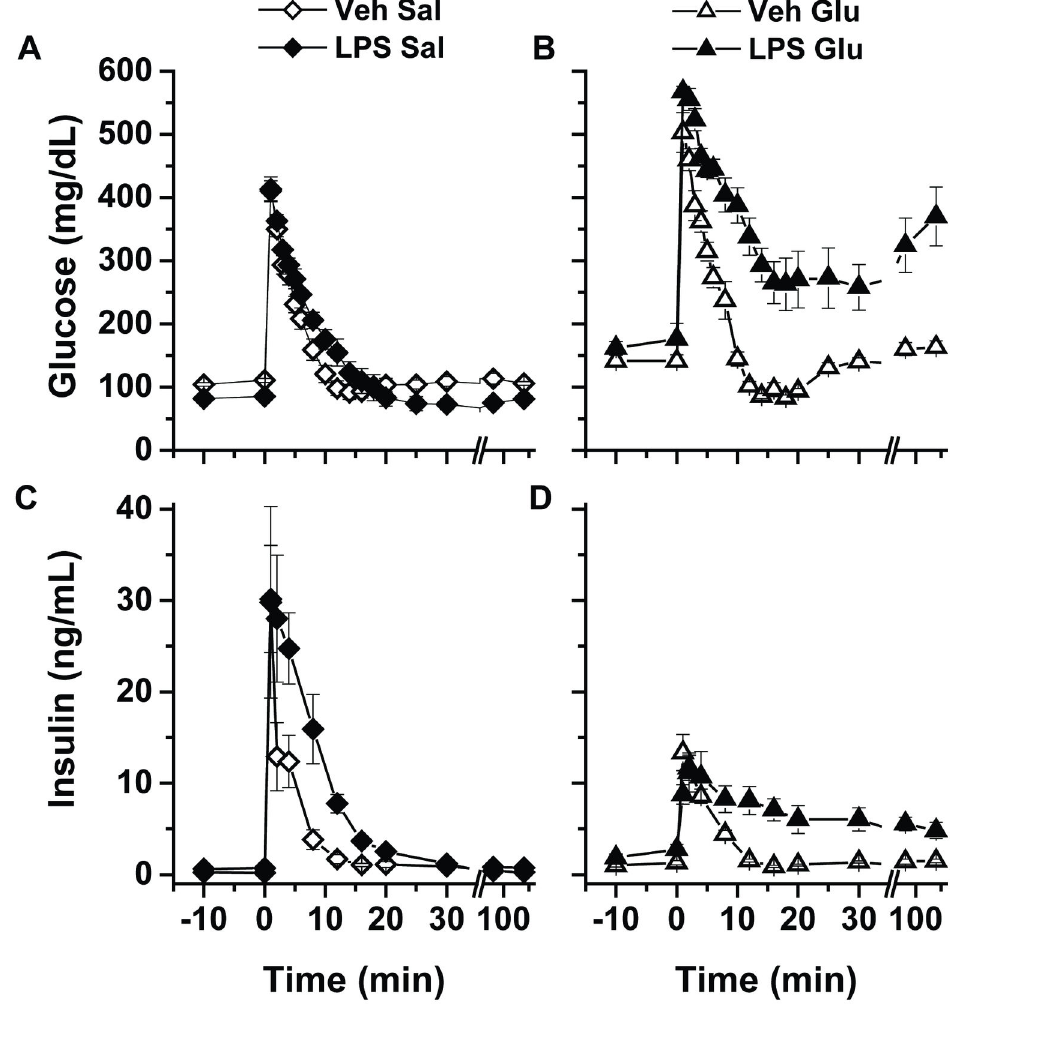
Figure 4. Frequently sampled intravenous glucose tolerance test data. Glucose disposal curves in response to an iv injection of 1 g/kg D50 administered over 15 sec at time t = 0 are depicted for (A) mice receiving iv saline infusion and vehicle (Veh Sal, open diamonds) or iv saline infusion and intra-arterial lipopolysaccharide (1 mg/kg, LPS Sal, closed diamonds) and (B) iv glucose infusion and vehicle (Veh Glu, open triangles) or mice receiving iv glucose infusion and LPS (1 mg/kg, LPS Glu, closed triangles). The corresponding insulin response curves are shown for (C) Veh Sal and LPS Sal and (D) Veh Glu and LPS Glu groups.